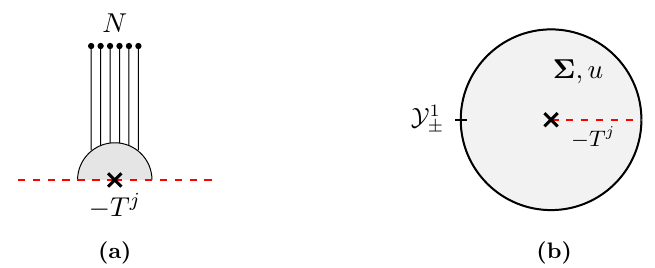
Figure 3. On the left the I (cid:6) junction. The representation with two copies of the branch cut will N;j be convenient for discussing gauge theory deformations. For I (cid:0) the monodromy is due to an O7 (cid:0) N;j with j + 4 D7 branes, for I + with j (cid:21) 4 it is due to an O7 + with j (cid:0) 4 D7 branes. On the right N;j the schematic form of the associated supergravity solution with one puncture at the center and one 5-brane pole on the